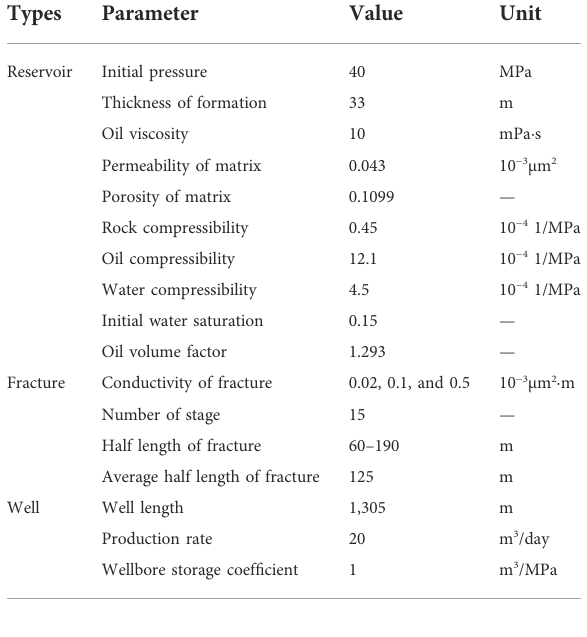
TABLE 1 Basic parameters of the reservoir, well, and fracture.